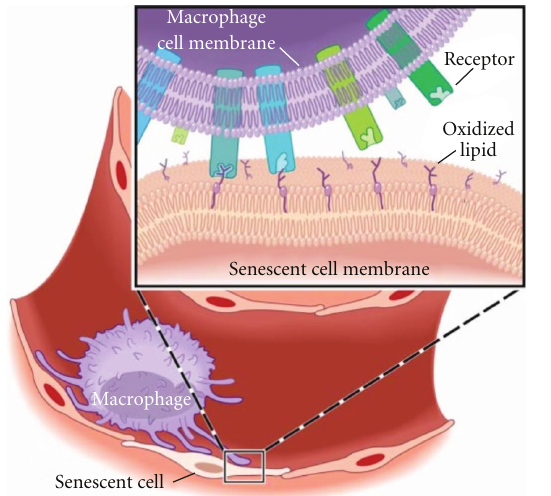
Figure 3: Oxidized phospholipids protrude from cell membranes in senescent endothelial cells forming oxidized lipid “whiskers.” Schematic representation of the lipid whisker model. Cell membranes of senescent endothelial cells can possess oxidized phospholipids with protruding sn -2-oxidized fatty acid acyl chains into the extracellular space. This conformation renders them accessible to interact with scavenger receptors and other pattern recognition receptors on the surface of platelets or probing macrophages of the circulatory and the immune system, adapted from [51].